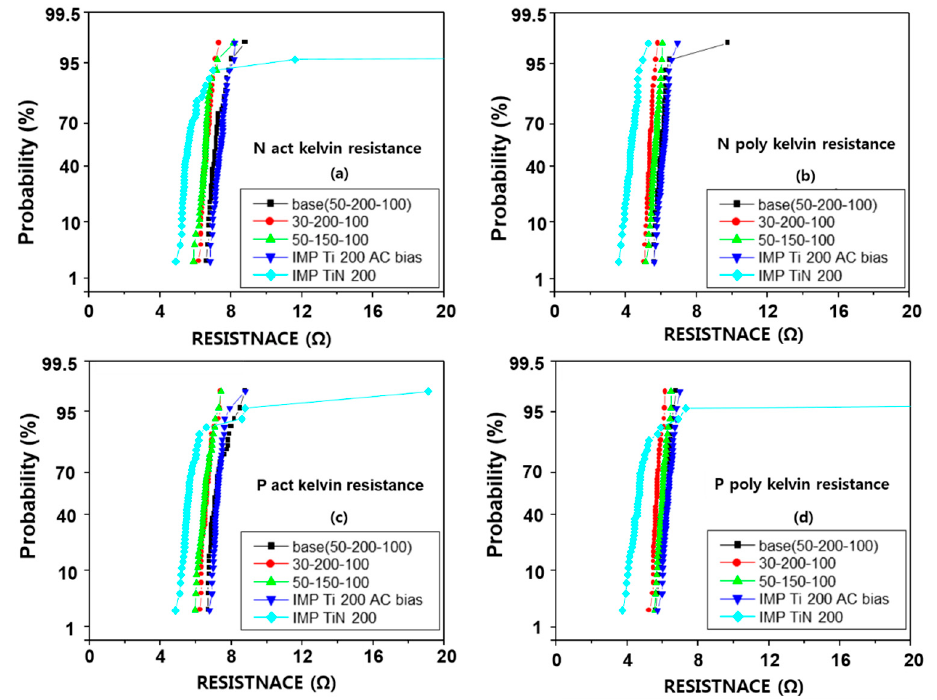
Figure 8. Electrical properties of ( a ) N act kelvin, ( b ) N poly kelvin, ( c ) P act kelvin, and ( d ) P poly contact resistance (Kelvin type) (unit: Å).